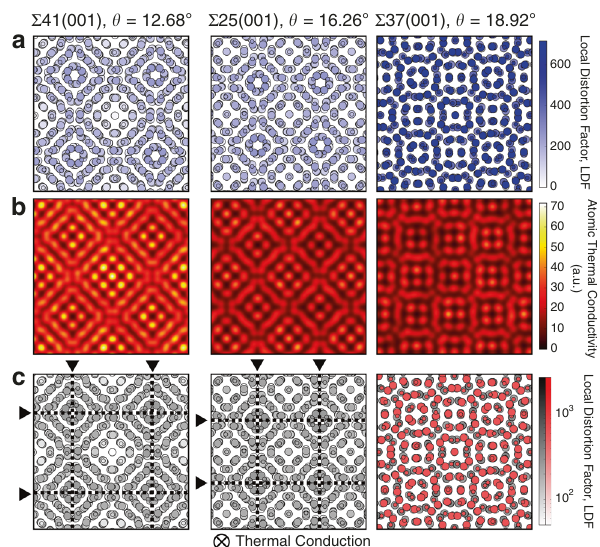
Fig. 5 Atomic con fi gurations and atomic thermal conductivities near GB planes of three twist GBs. a Local distortion factors, LDFs; b Gaussian- smeared atomic thermal conductivities; c Distributions of LAE groups classi fi ed using hierarchical clustering. Dislocation lines are shown as dashed lines in c . A log scale is used for LDF values in c to make it easier to distinguish differences within LAE